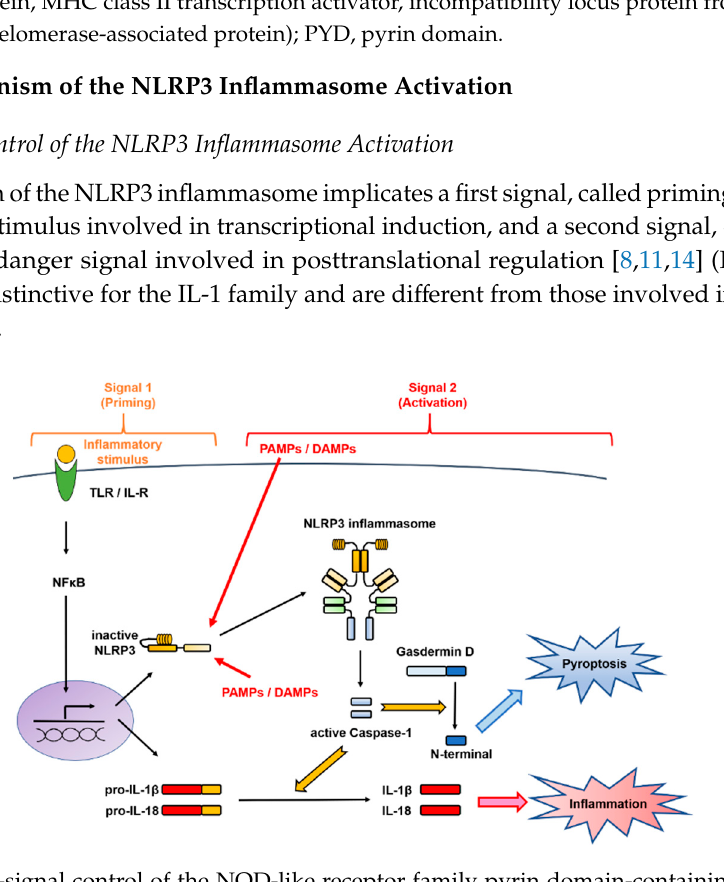
Figure 2. Two-signal control of the NOD-like receptor family pyrin domain-containing 3 (NLRP3) inflammasome activation. Activation of the NLRP3 inflammasome implicates a first signal, called priming, which requires an inflammatory stimulus involved in transcriptional induction, and a second signal, called triggering, which requires a danger signal involved in posttranslational